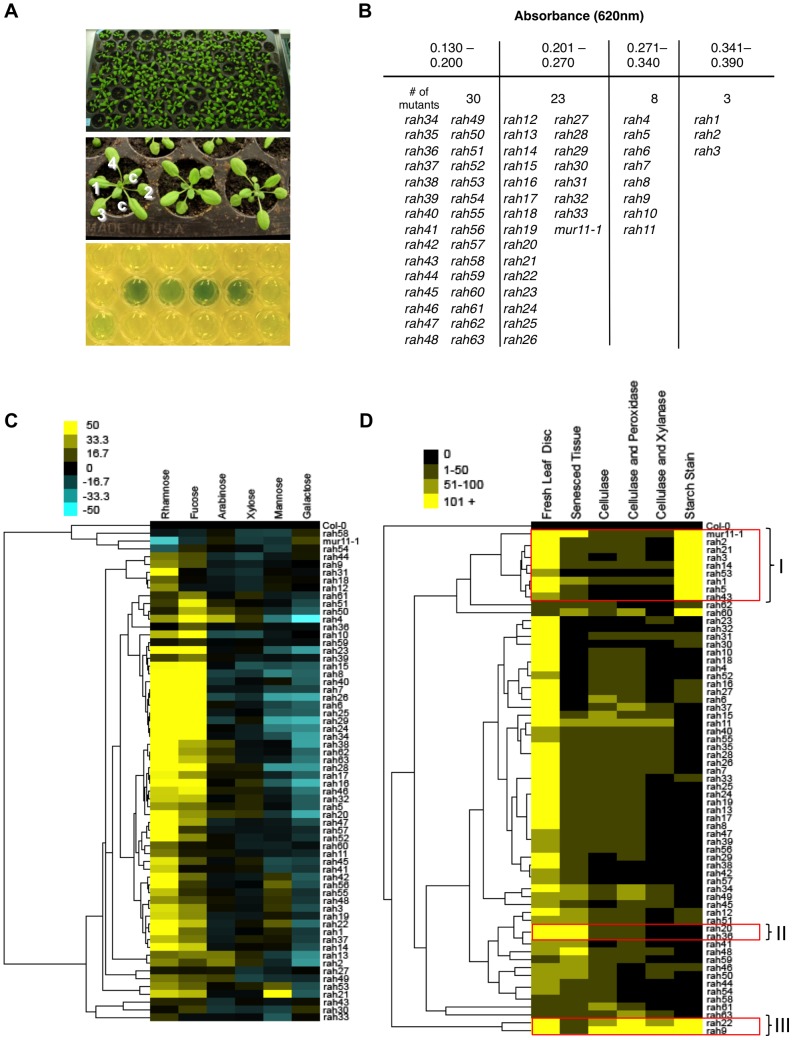
Characterization of rah mutants.(A) Three-week old Arabidopsis plants grown in 96-well flats at 22°C under a 16 h/8 h light/dark cycle (top panel). Leaf 3 or 4 was excised from 21 day-old plants using a hole punch and subjected to acid hydrolysis using 1 M H2SO4 (middle panel). c, cotyledon; leaf numbers indicated. Results of colorimetric anthrone assay illustrating that rah mutants release more sugars and turn a blue/green colour. Yellow indicates baseline levels of sugar release (bottom panel). (B) From the screen, 63 rah mutants and mur11-1 were isolated and organized into 4 categories of low to high yielding sugar mutants. (C) Hierarchical cluster analysis of monosaccharide composition analysis by gas chromatography of rah mutants in 21 day-old seedlings. Values shown as a percentage relative to wild type (see Methods). Yellow indicates higher levels than wild type; blue, lower levels. (D) Clustered heatmap of sugar content as measured by the anthrone method from 63 rah mutants subjected to acid hydrolysis of fresh leaf tissue using 1 M H2SO4, acid hydrolysis of senesced stem tissue using 0.2 M H2SO4, or glucose content (using hexokinase method) of cellulase, cellulase+xylanase and cellulase+peroxidase digested senesced tissue and starch staining of 14 day-old seedlings. Values shown as a percentage relative to wild type (see Methods). Yellow indicates high levels of sugar; black, low levels of sugar. Mutants with similar characteristics have been classified into 3 subcategories (I, II and III) and outlined in red.